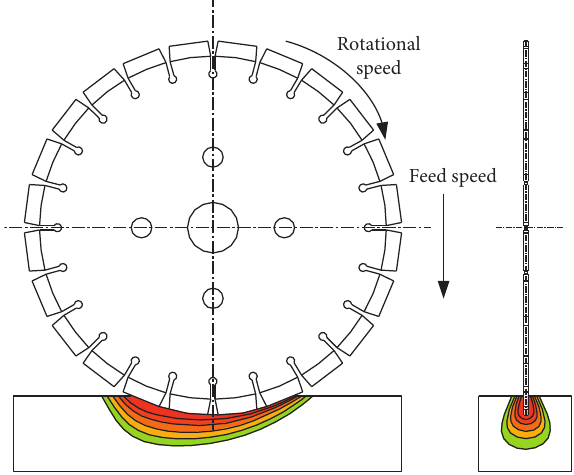
Figure 6: Stress distribution in the process of the diamond sawblade cutting into rock.